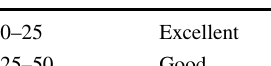
Table 2 Water quality index and water quality